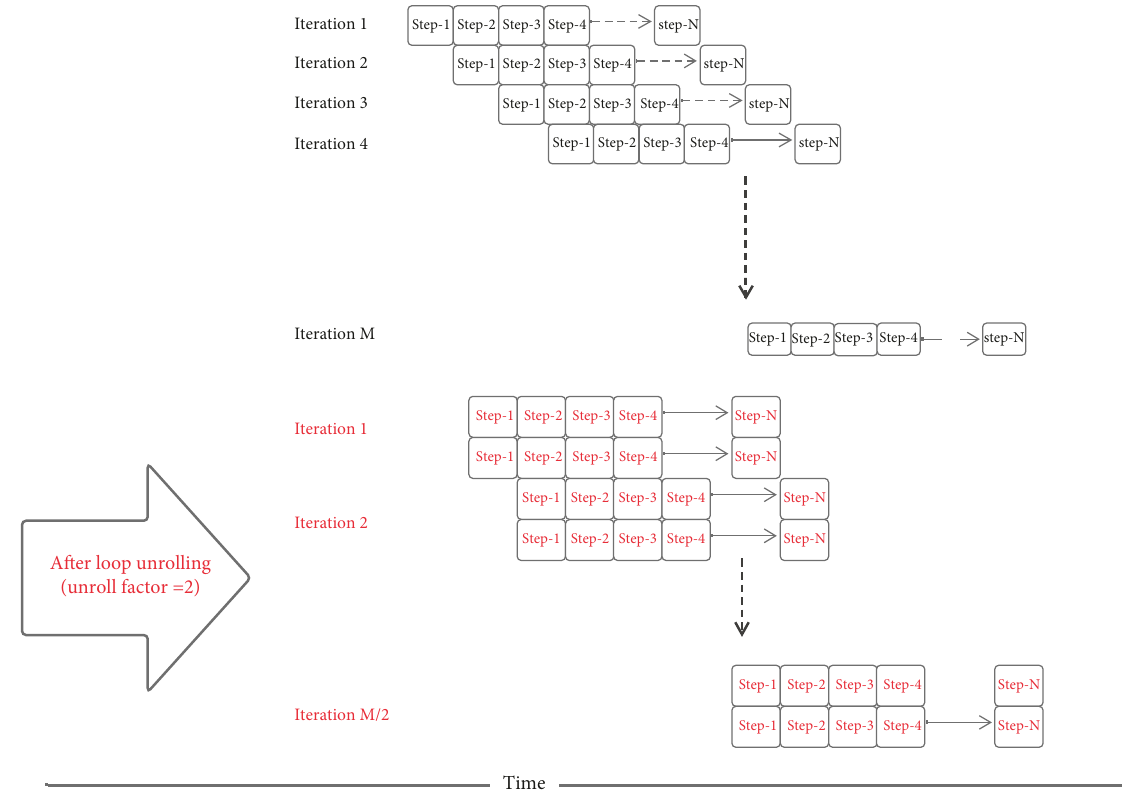
Figure 3: Reducing the number of iterations using the loop unrolling technique.